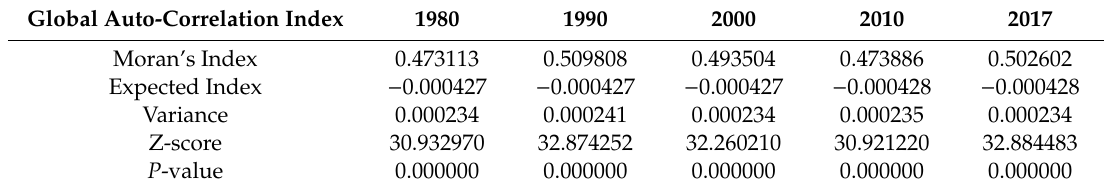
Table 7. Results of the global auto-correlation analysis in the study